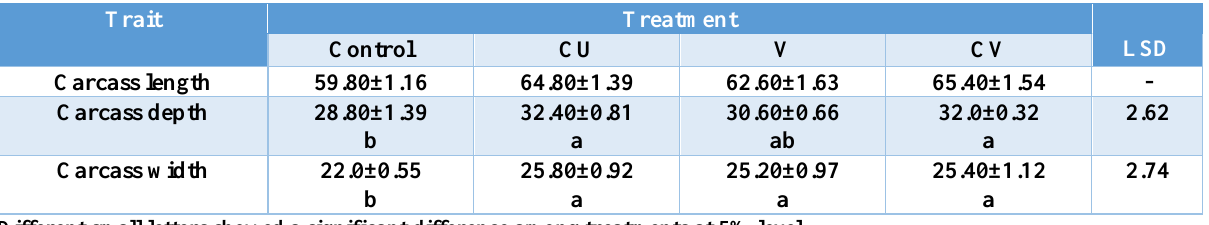
Table, 3: Effects of vasectomy and/or adding Cuminum cyminum in the diet on carcass measurements (cm) of Awassi male lambs (Mean ±